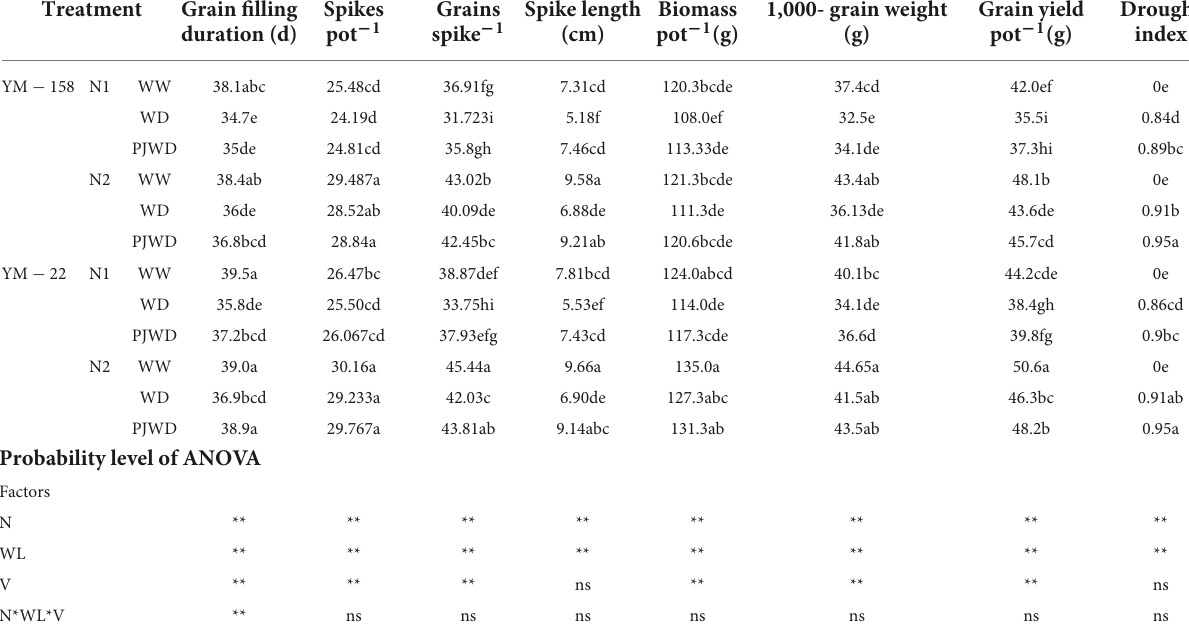
TABLE 2 Effects of pre-drought priming and nitrogen on grain yield and its components under post-anthesis drought stress in Yangmai-158 (YM-158) and Yangmai-22 (YM-22) wheat cultivars.